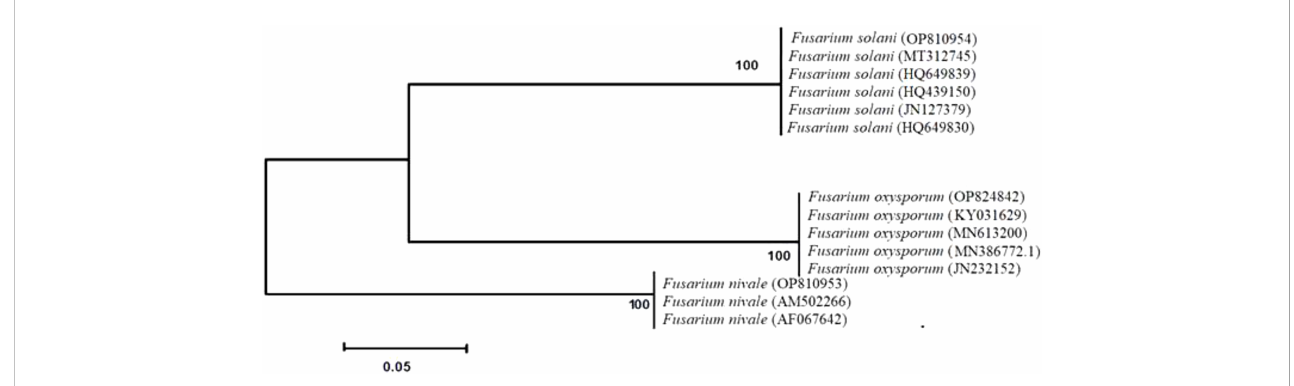
FIGURE 1 Phylogenetic analysis obtained by sequence analysis of Fusarium isolates 18S rDNA-ITS-region. Bootstrap tests were performed with 1,000